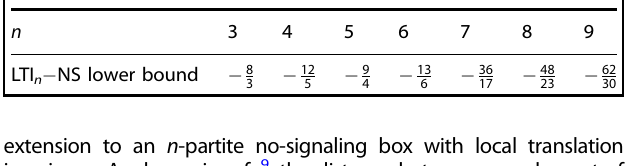
Table 1. Exact solutions of LTI n − NS approximations of the lower bound of (15) as a function of n .